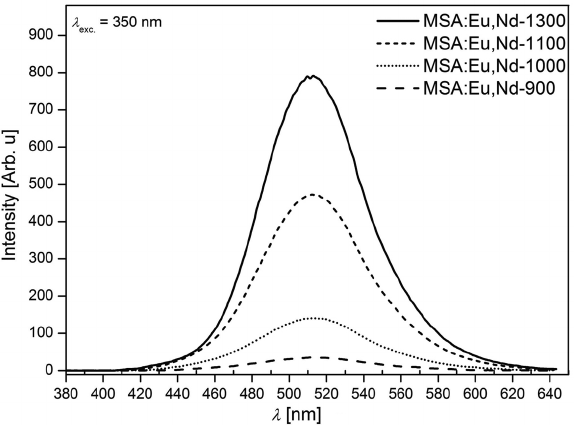
Figure 3. UV-excited ( λ = 350 nm) emission spectra of the exc. MSA:0.5Eu 2+ ,0.25Nd 3+ samples annealed at various temperatures in a reducing atmosphere, measured at room temperature. The le- gend of the curves is ordered by appearance.